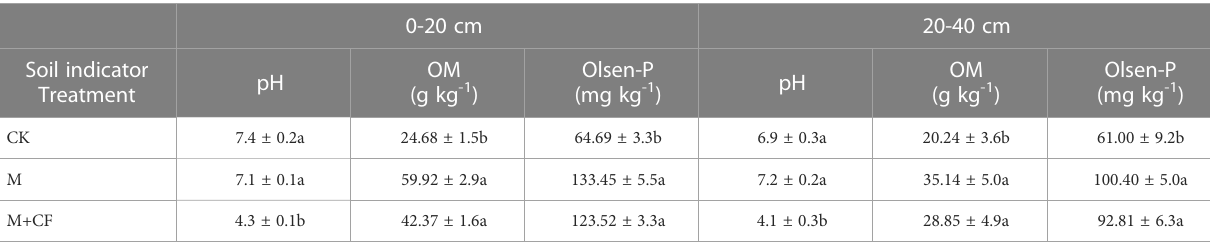
TABLE 1 Soil indicators of three treatments in different soil